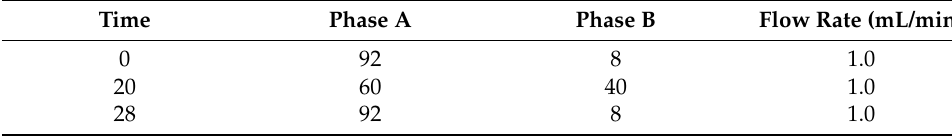
Table 8. HPLC mobile phase gradient